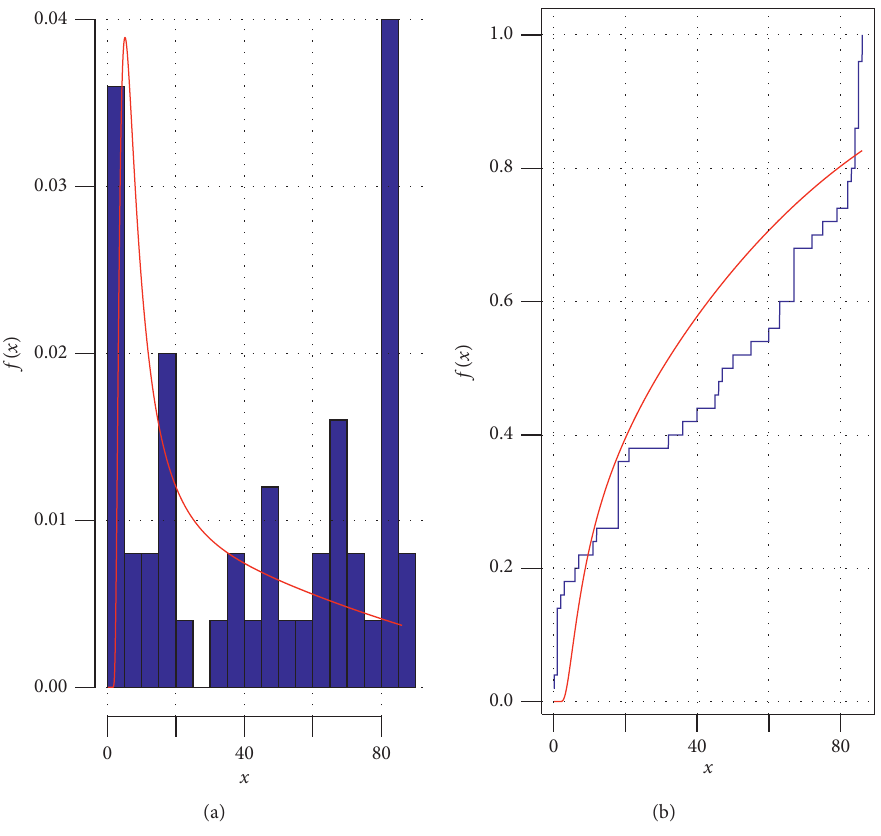
Figure 8: The EPDF (a) and the EHRF (b) for lifetimes data.